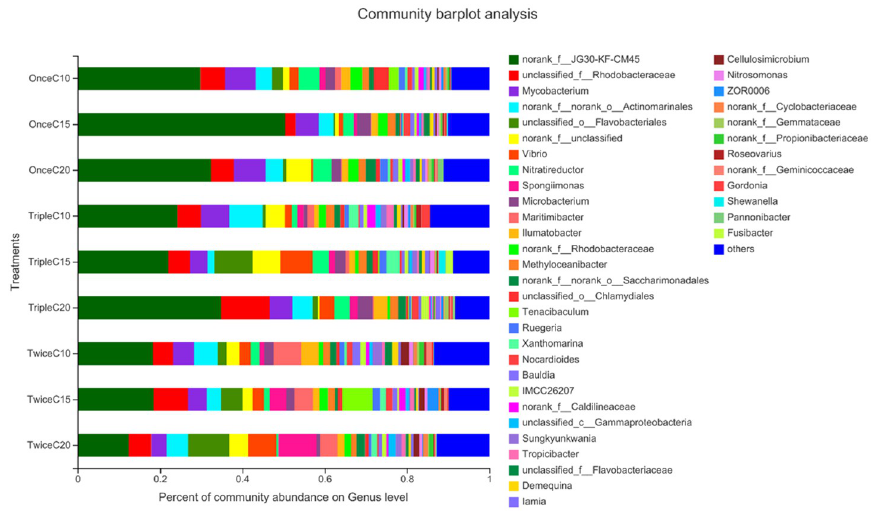
Fig 8. Relative abundance of the most prevalent bacterial genus identified in the intestine of Litopenaeus vannamei reared in biofloc under different frequent addition times of carbon source (starch) (once, twice, triple) on daily basis and C/N ratios (10, 15, 20). T1; once C/N 10, T2; once C/N 15, T3; once C/N 20, T4; twice C/N 10, T5; twice C/N 15, T6; twice C/N 20, T7; triple C/N 10, T8; triple C/N 15, T9; triple C/N 20.